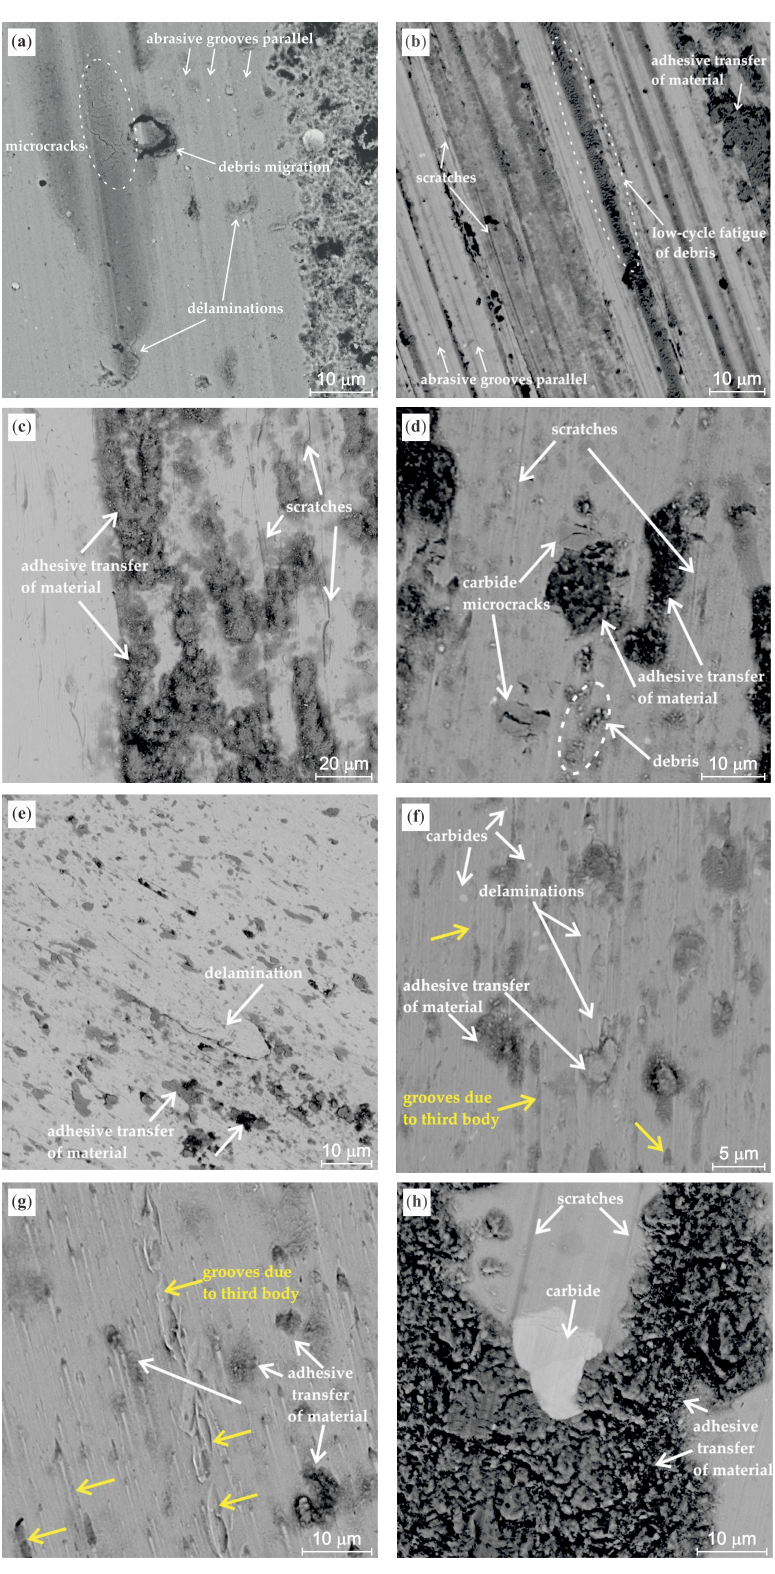
Figure 7. SEM microphotographs of the worn surfaces of: ( a ) K340/AlCrSiN; ( b ) K340; ( c ) 90MnCrV8; ( d ) X155CrVMo12-1; ( e ) 40CrMnMo7; ( f ) X37CrMoV5-1; ( g ); and X40CrMoV5-1 ( h